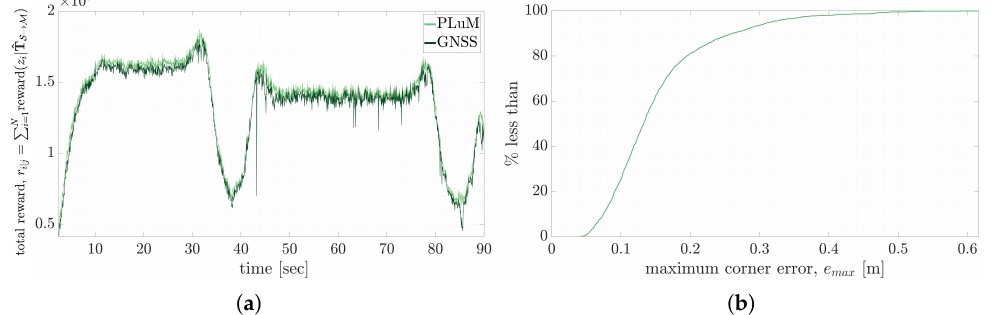
Figure 20. ( a ) Compares the maximum reward for the PLuM pose estimates and the reported GNSS solution. The reward is similar, with the PLuM algorithm reporting a slightly higher reward on average. ( b ) Displays a cumulative distribution function for the maximum vertex error for the 90 s loading cycle.